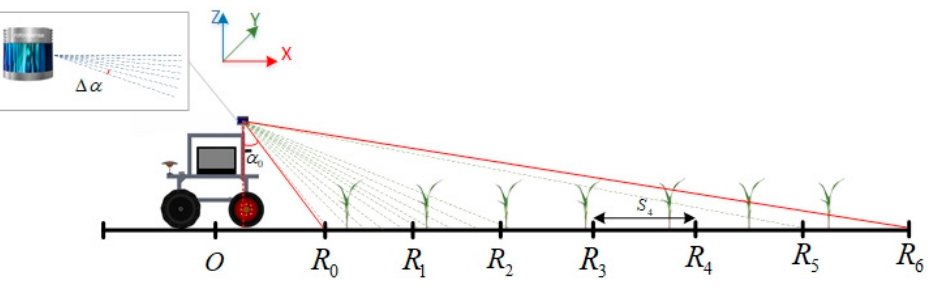
Figure 3. Illustration of the LiDAR scanning harness.